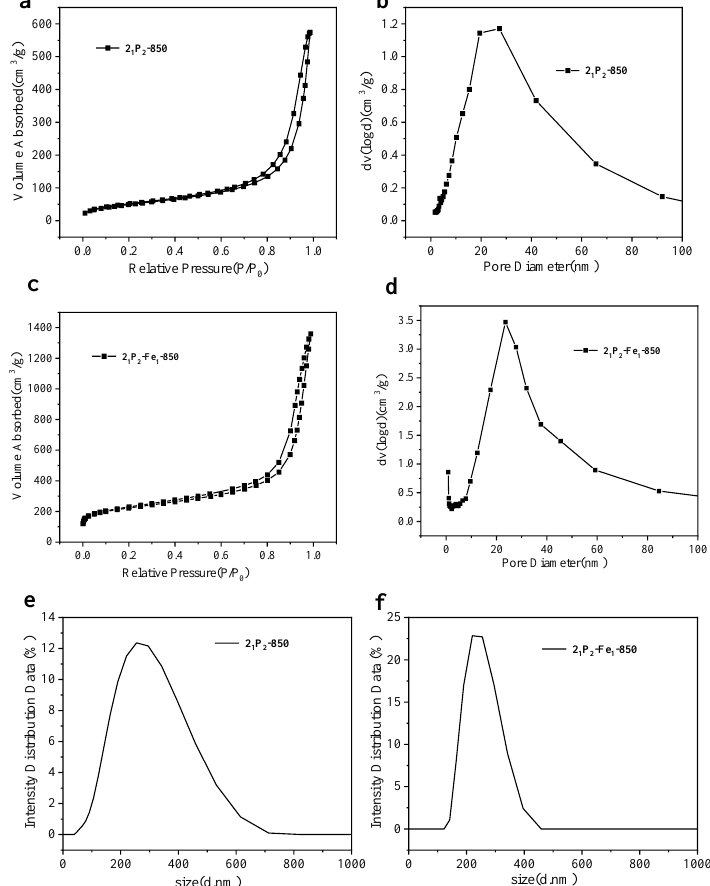
Figure 4. ( a ) N 2 adsorption–desorption curves for 2 1 P 2 -Fe 1 -850 and ( b ) pore size distribution curves. ( c ) N 2 adsorption–desorption curves for 2 1 P 2 -850 and ( d ) pore size distribution curves. ( e , f ) Size and size distribution of 2 1 P 2 -850 and 2 1 P 2- Fe 1 -850. 2 1 P 2 -Fe 1 -850 has a specific surface area of 1315 m 2 g − 1 , which is larger than that of 2 1 P 2 -